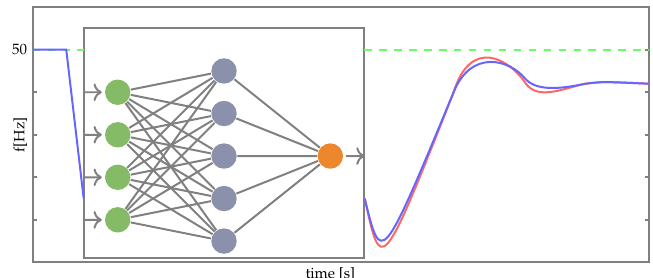
Figure 7. Applied